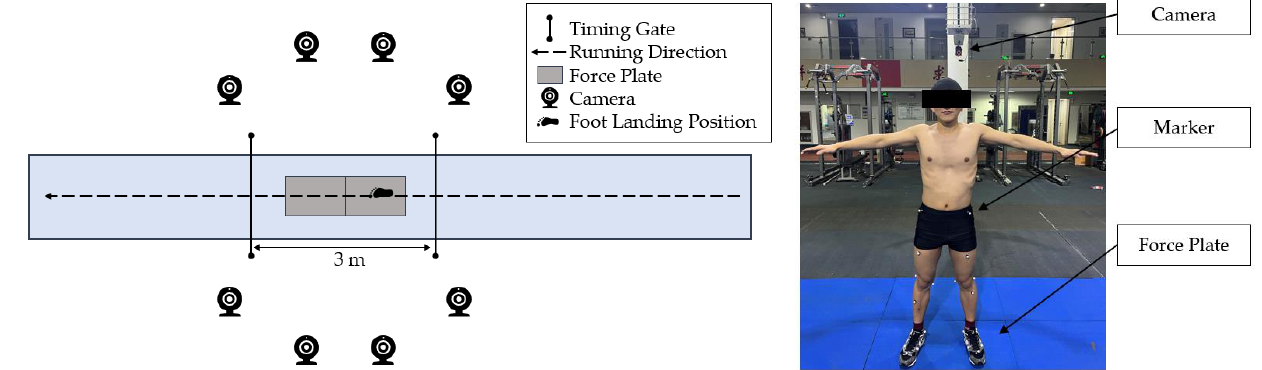
Figure 2. Experiment setup and marker placement.